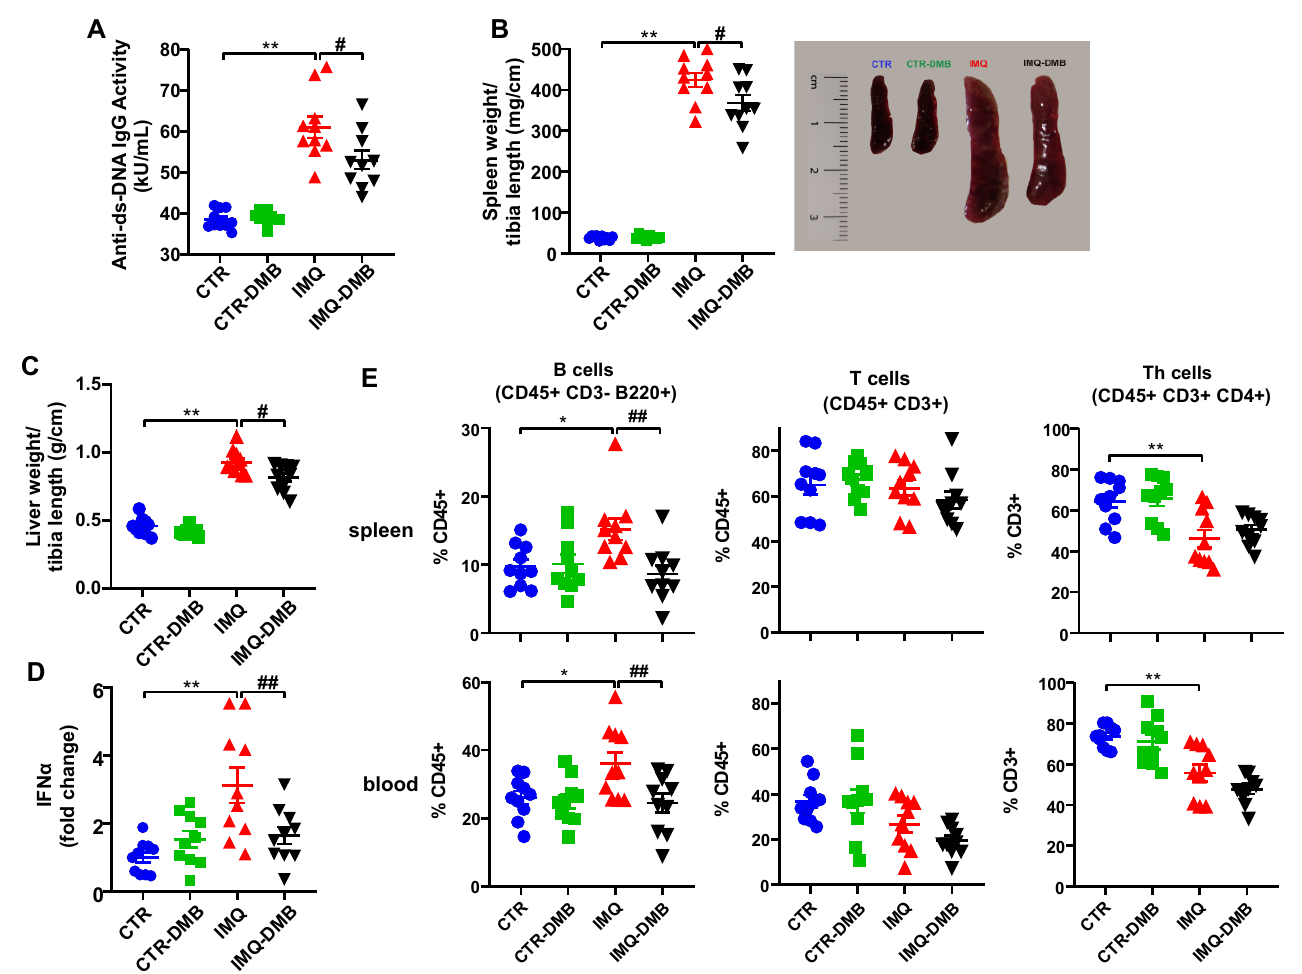
Figure 2. Effects of 3,3-dimethyl-1-butanol (DMB) treatment on disease activity signs in the imiquimod (IMQ) group. ( A ) Circulating double-stranded DNA (anti-ds-DNA); ( B ) splenomegaly; ( C ) hepatomegaly; ( D ) IFN α mRNA levels in MLNs; and ( E ) percentage of B, T, and Th cells in spleen and blood in CTR, CTR-group treated with DMB (CTR-DMB), IMQ, and IMQ-group treated with DMB (IMQ-DMB). The data are expressed in a means ± SEM format. Comparisons between variables were performed with one-way ANOVA and Tukey’s post hoc test, or Kruskal–Wallis test with Dunn’s multiple comparisons. * p < 0.05 and ** p < 0.01 in comparison with CTR; # p < 0.05 and ## p < 0.01 in comparison with IMQ.